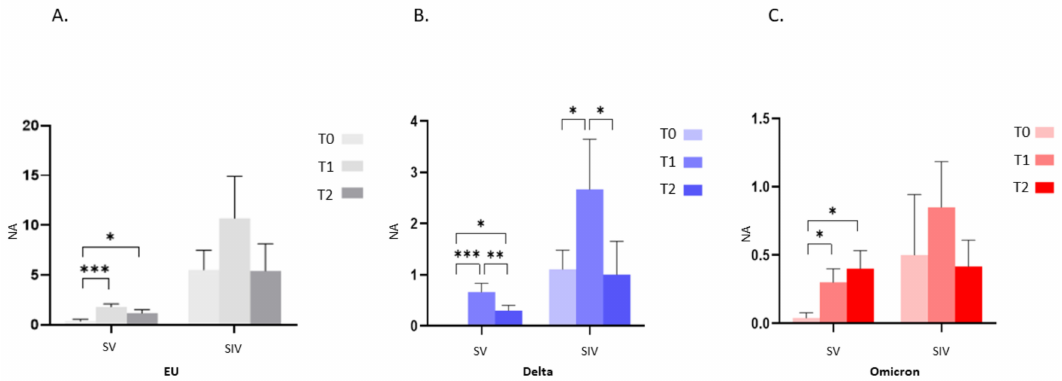
Figure 6. Saliva neutralizing activity (NA) trend over time. NA significantly increased from T0 to T1 and decreased from T1 to T2 against the EU ( A ), Delta ( B ) and Omicron ( C ) variants in both SV and SIV. Mean values ± SE are reported. * p < 0.05, ** p < 0.01, *** p <